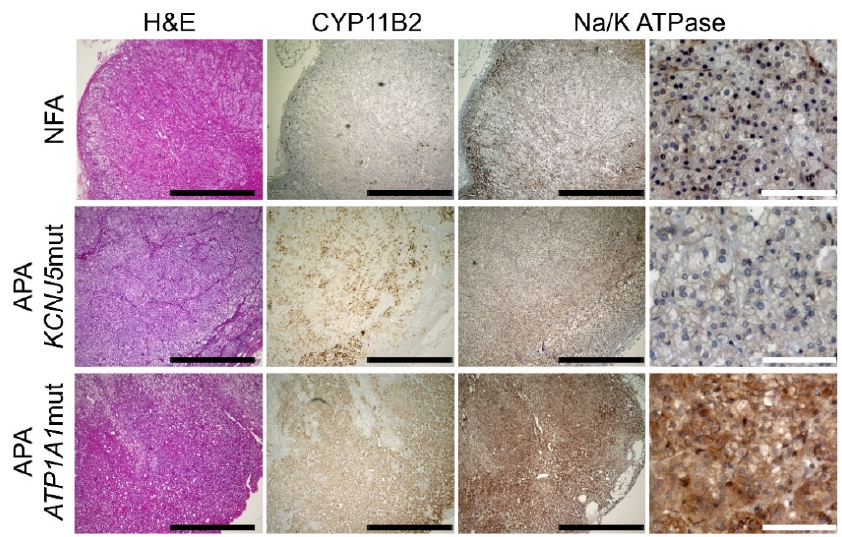
Figure 2. Immunohistochemical detection of sodium/potassium-transporting ATPase (NKA) in al- dosterone-producing adenomas (APA) with an ATP1A1 or KCNJ5 mutation and a non-functioning adrenocortical adenoma (NFA). Black and white scale bars indicate 1 mm and 100 μ m,